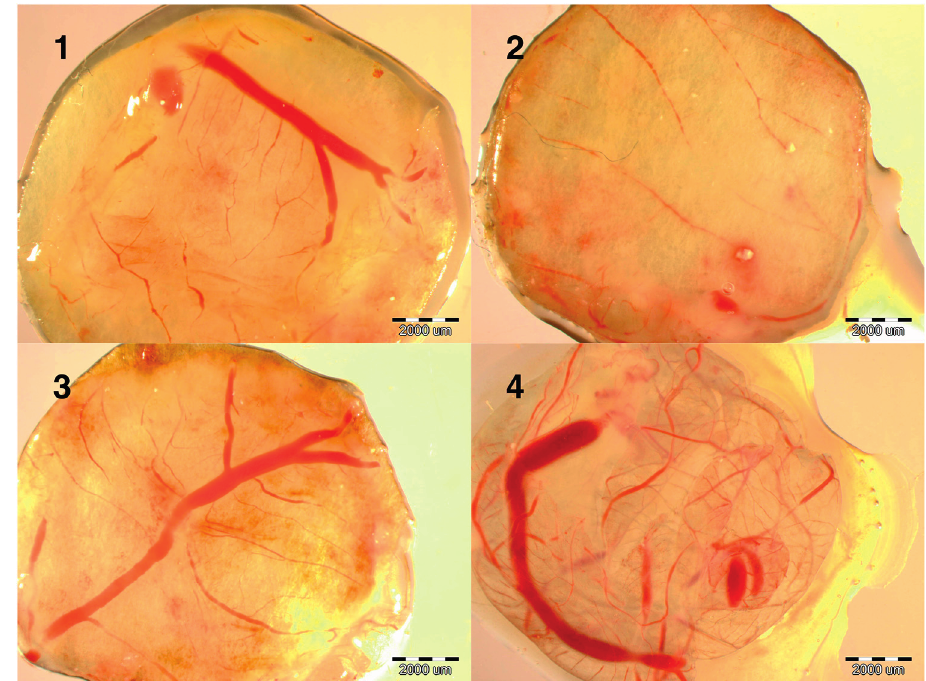
Figure 1. Images of implants maintained on the chicken embryo chorioallantoic membrane (CAM) for 2 days, soaked with: ( 1 ) control (not soaked); ( 2 ) control (PBS); ( 3 ) CuSO 4 ; ( 4 ) NanoCu, evaluated at day 12 of incubation. Scale bars, 2000